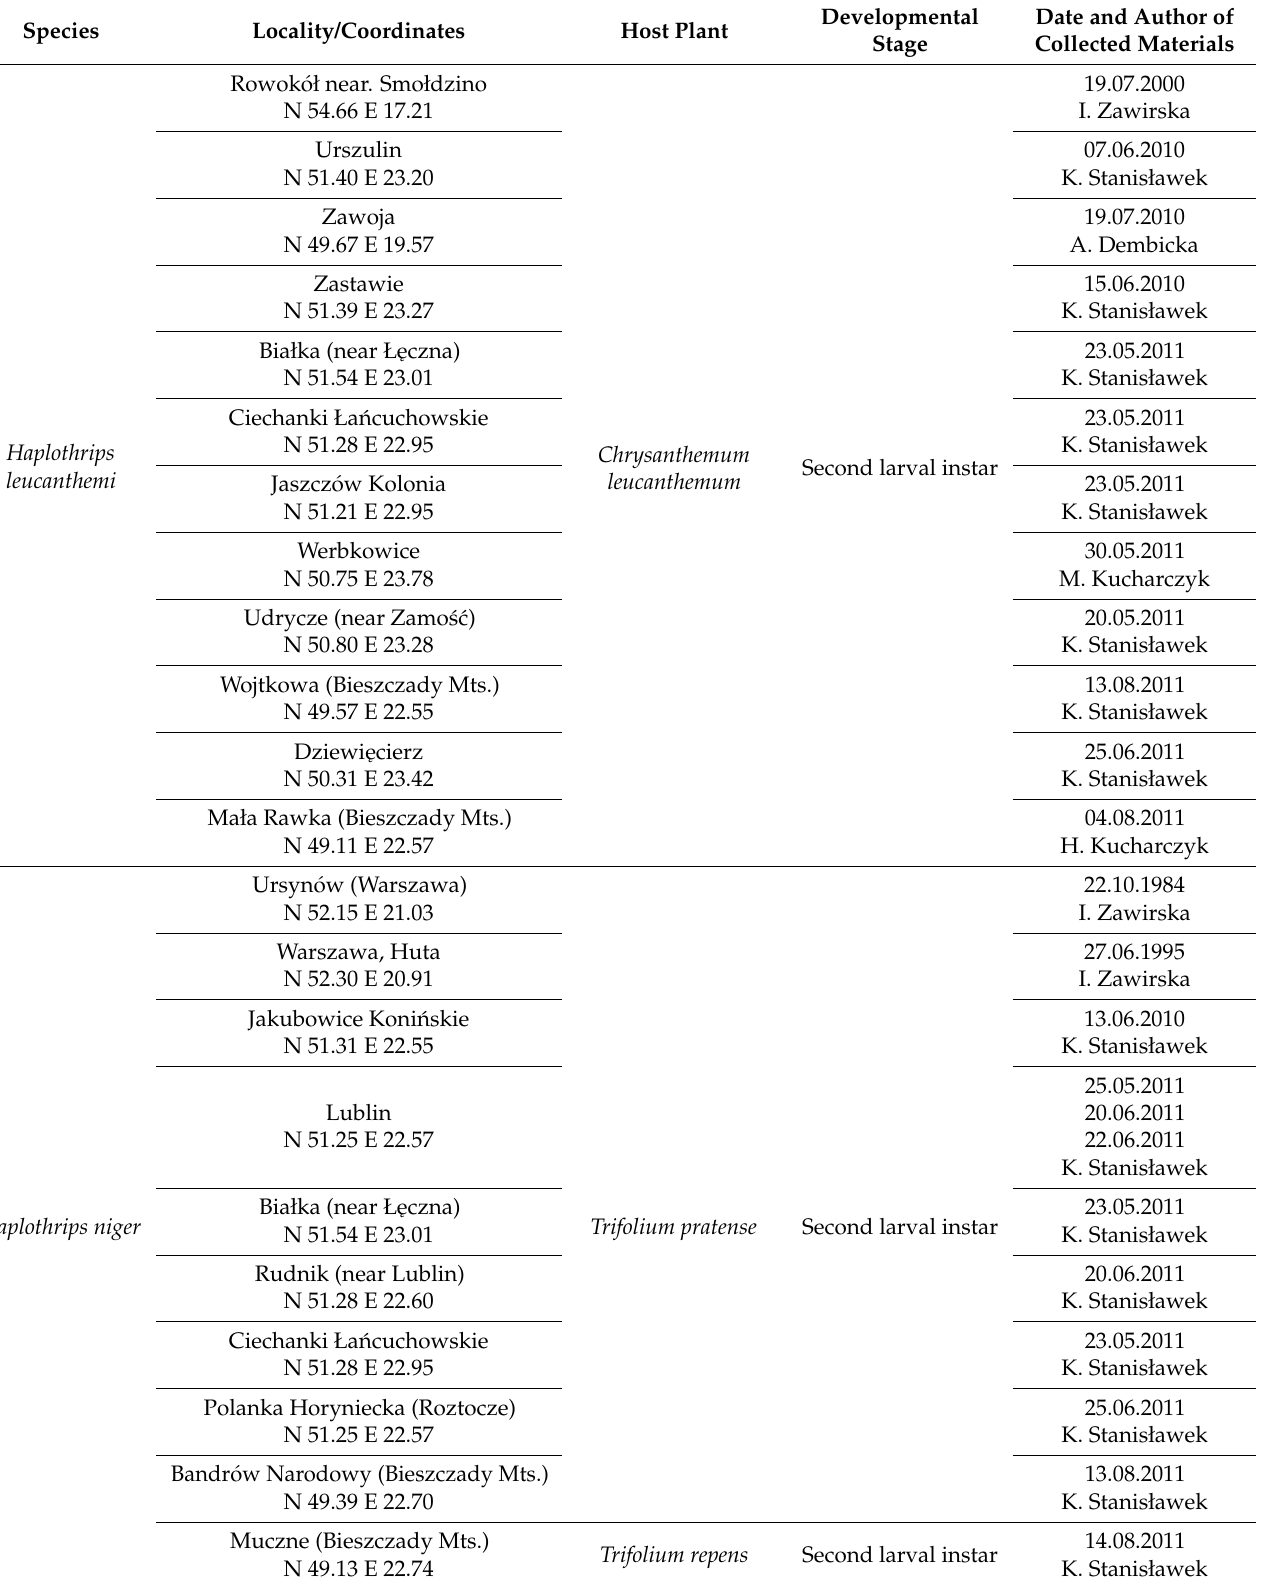
Table A1. Detailed information about sampling sites of archival specimens of both Haplothrips leucanthemi and H. niger used for further morphometric